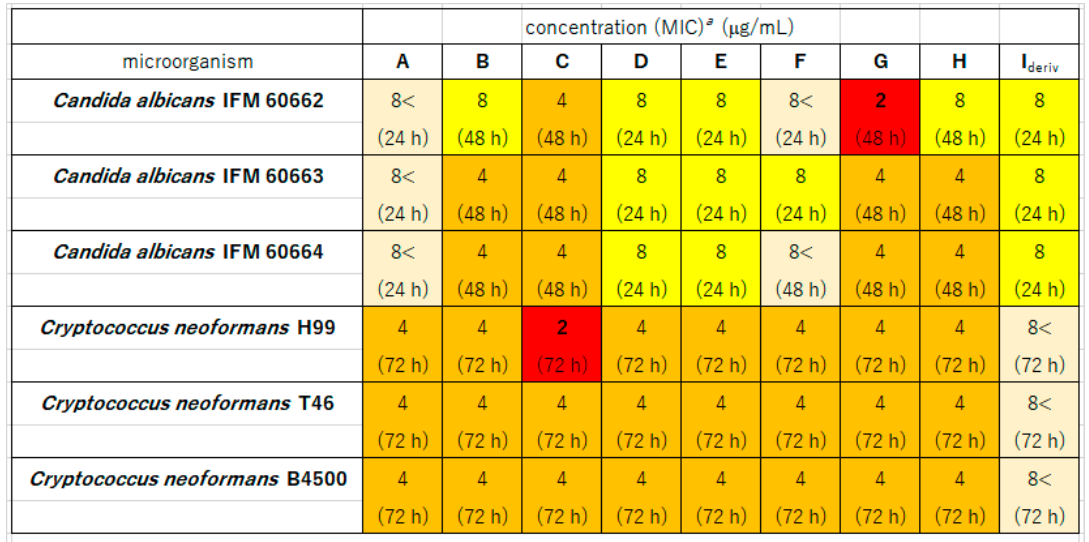
Figure 3. Antifungal activity of eushearilide congeners A – H and I deriv .